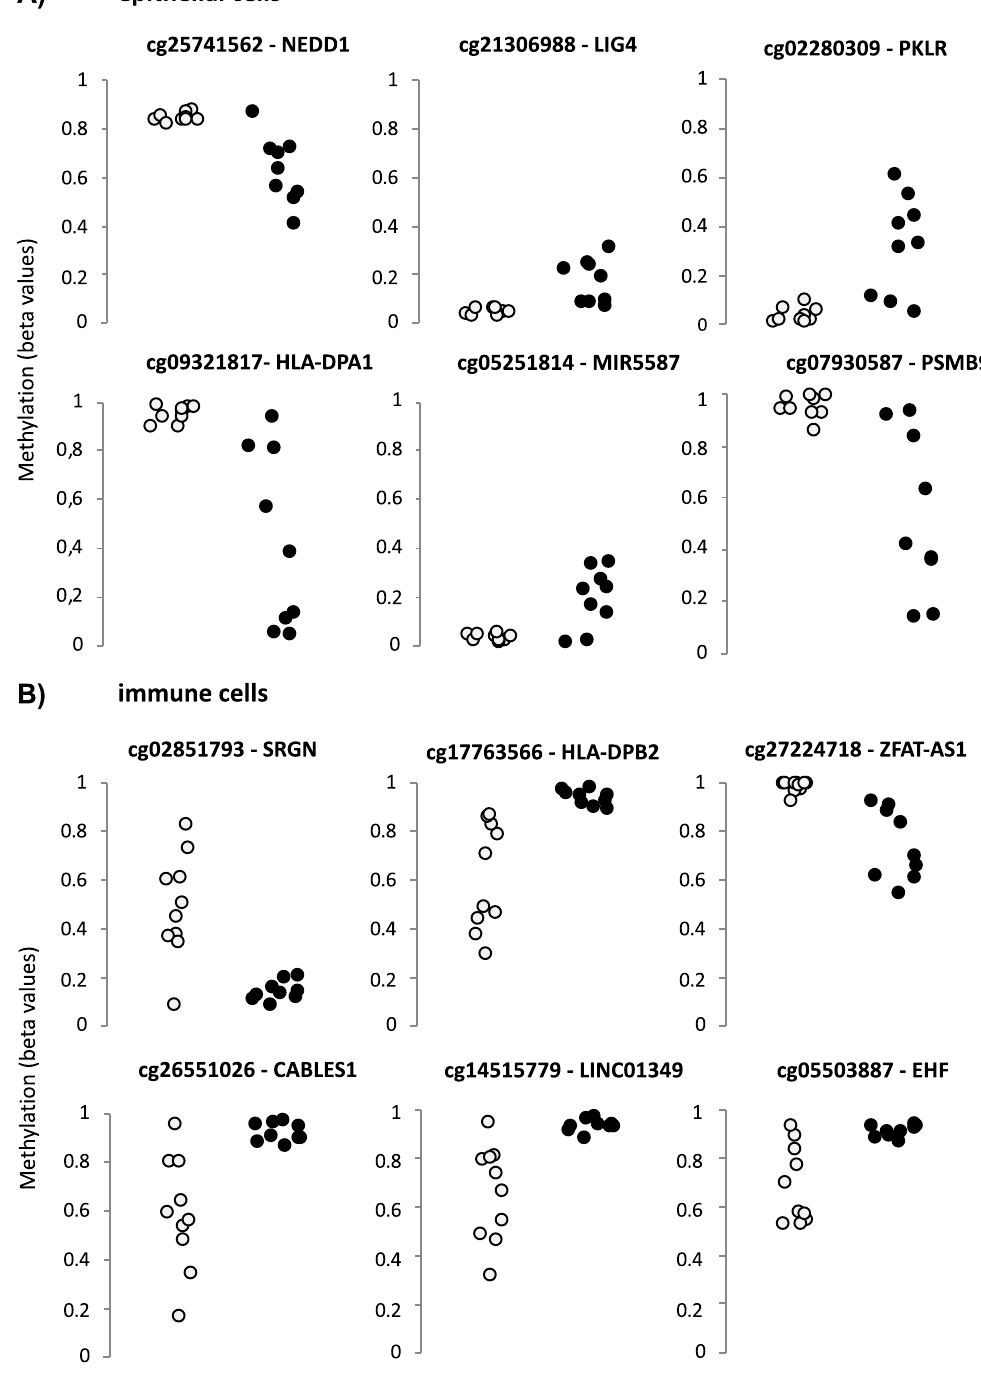
Figure 3. Most variably and differentially methylated positions in each cell type. The figure shows the top DVMCs per cell fraction, according to the iEVORA R package, as described in Methods . Grey and black circles represent control and celiac samples,